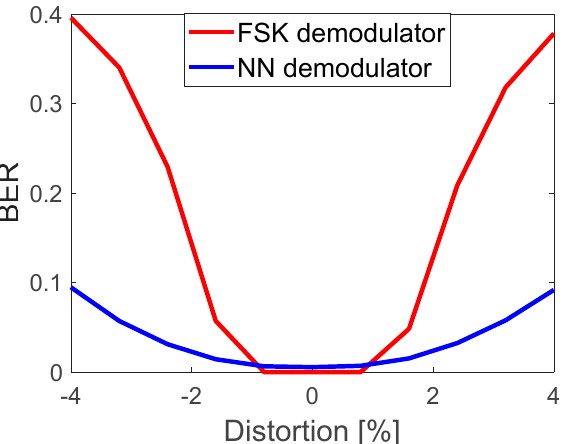
Figure 15. Hard-decision FSK correlator-based and NN-based demodulator. BER performance vs. e abs [%].